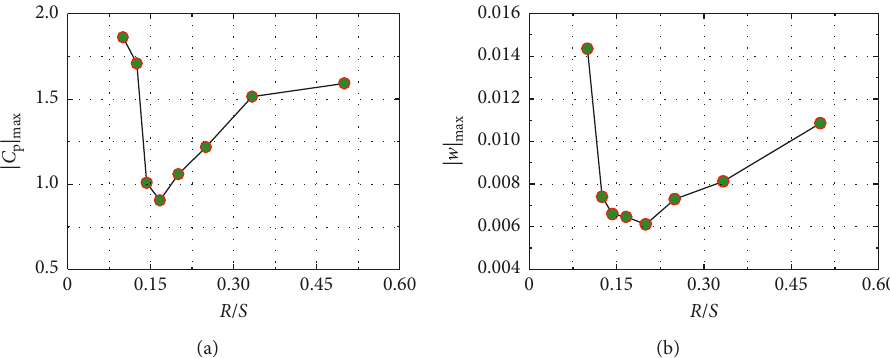
Figure 10: Variations of the highest mean suction and the maximum response displacement among all surface nodes with different rise- to-span ratios ( R / S ). (a) | C